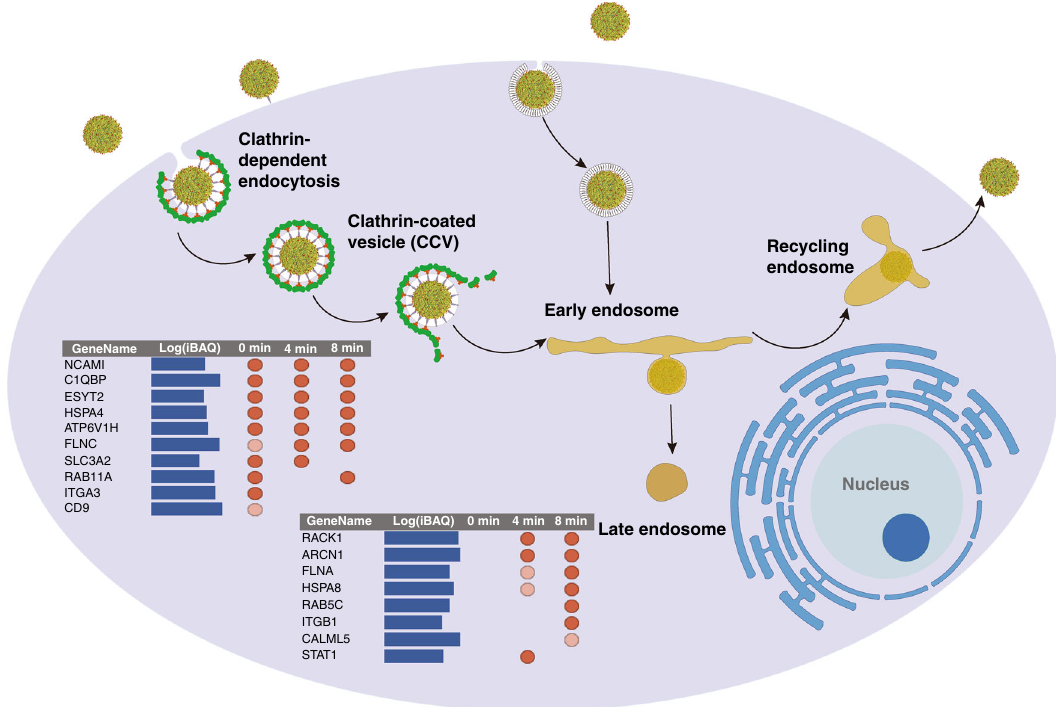
Fig. 3 Proposed endocytosis pathways of ZIKV entry into host cells. Temporal illustration of ZIKV-crosslinked proteins involved in major endocytic mechanisms for ZIKV internalization. Listed are proteins crosslinked at different time points of infection. Blue bar indicated log(iBAQ) intensity. Red dot denoted crosslinked proteins at speci fi c time point, dark red indicated log2-fold change between samples and control >2, and light red indicated log2-fold change between samples and control is between 1 and 2. A detailed list of these proteins with p value is shown in Supplementary Data